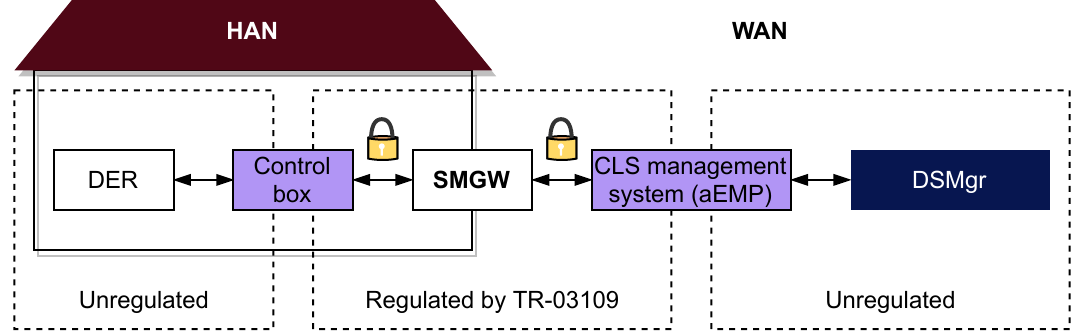
Figure 3. Controllable local system (CLS) management systems encapsulate